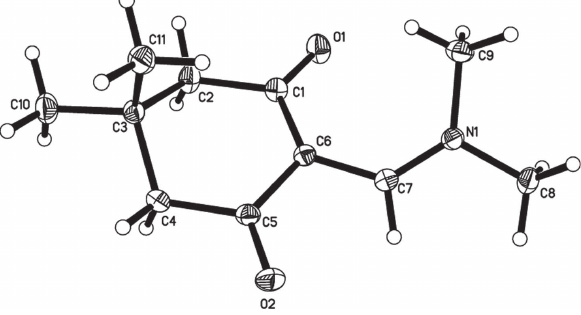
Table 1: Data collection and